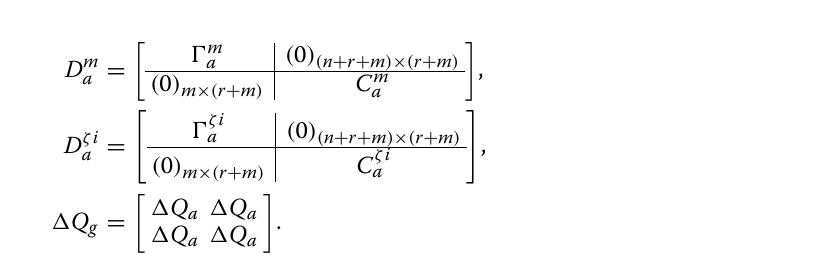
Fig. 2 The actual smoothing error curves of the third component of CF one-step smoother and the h )( 3 ) ( 3 ) corresponding ± 3 σ ( c ( 1 ) and ± 3 σ c ( 1 )